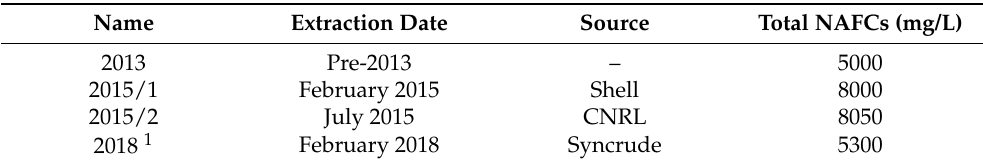
Table 1. Summary of information for the OSPW extracts employed for evaluation of CP-MIMS membrane permeability.